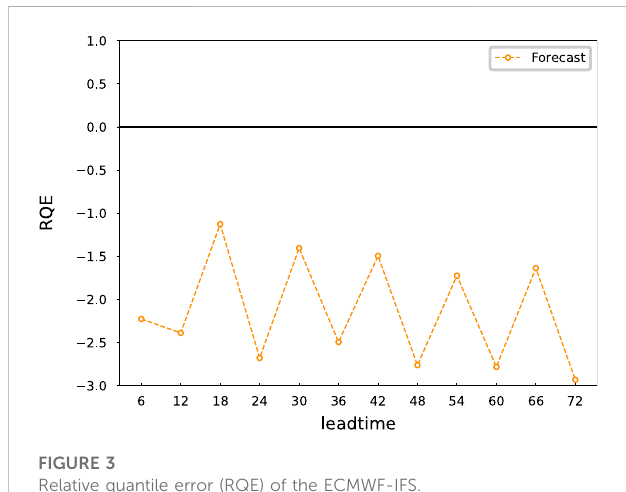
FIGURE 3 Relative quantile error (RQE) of the ECMWF-IFS.